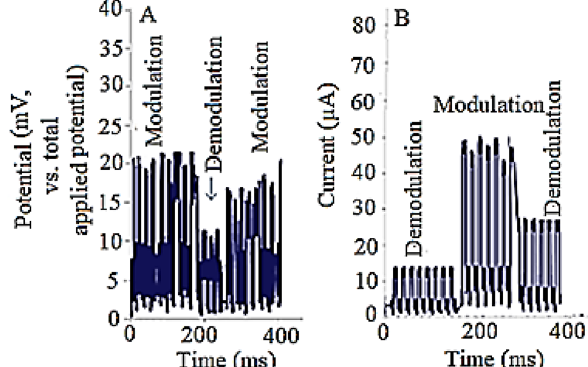
Figure 8. Effects of different sequential AP’s de-modulations on the ( A ) electrical potential and ( B ) measured electrical currents during in-vitro analysis of snail’s brain-connected spinal cord using bliny potentiometry (at giga seal condition) and current-based patch-clamp method.